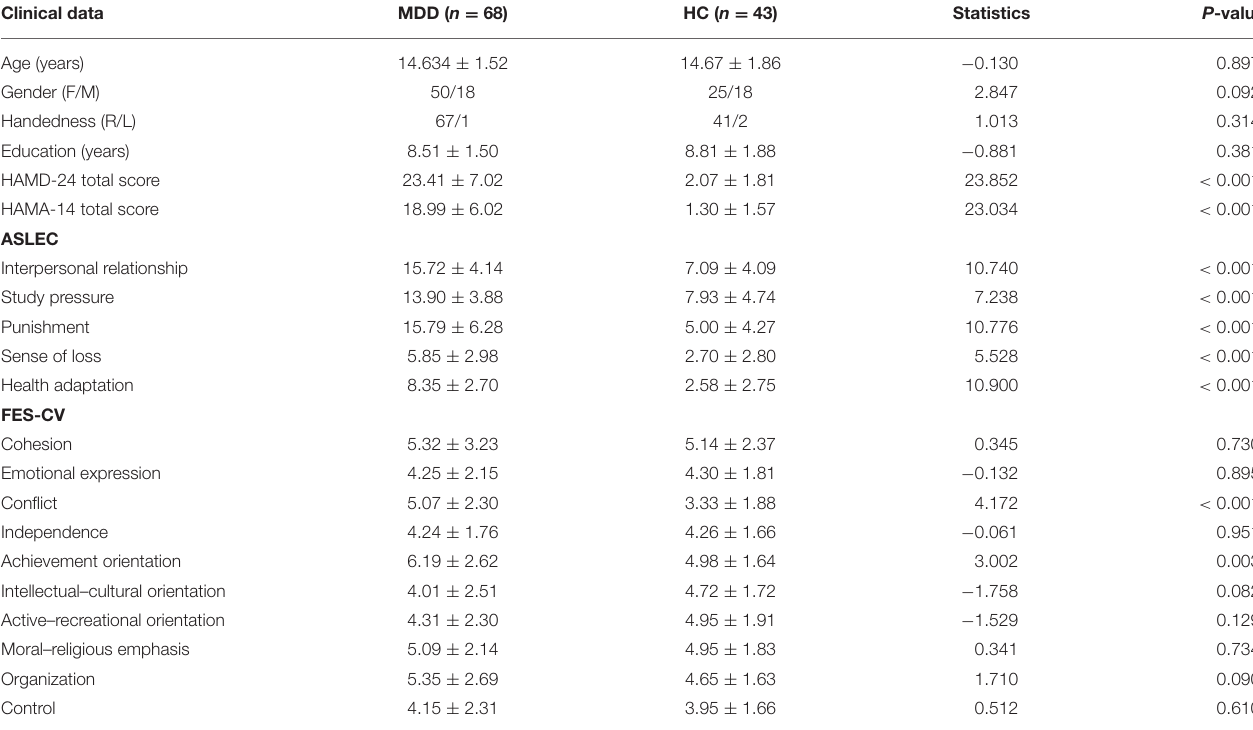
TABLE 1 | Demographic and clinical variables in patients with MDD and HC